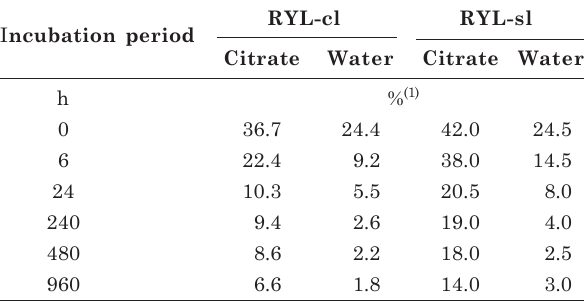
(1) Percentage of P in relation to the applied rate, equivalent to 50 % of the